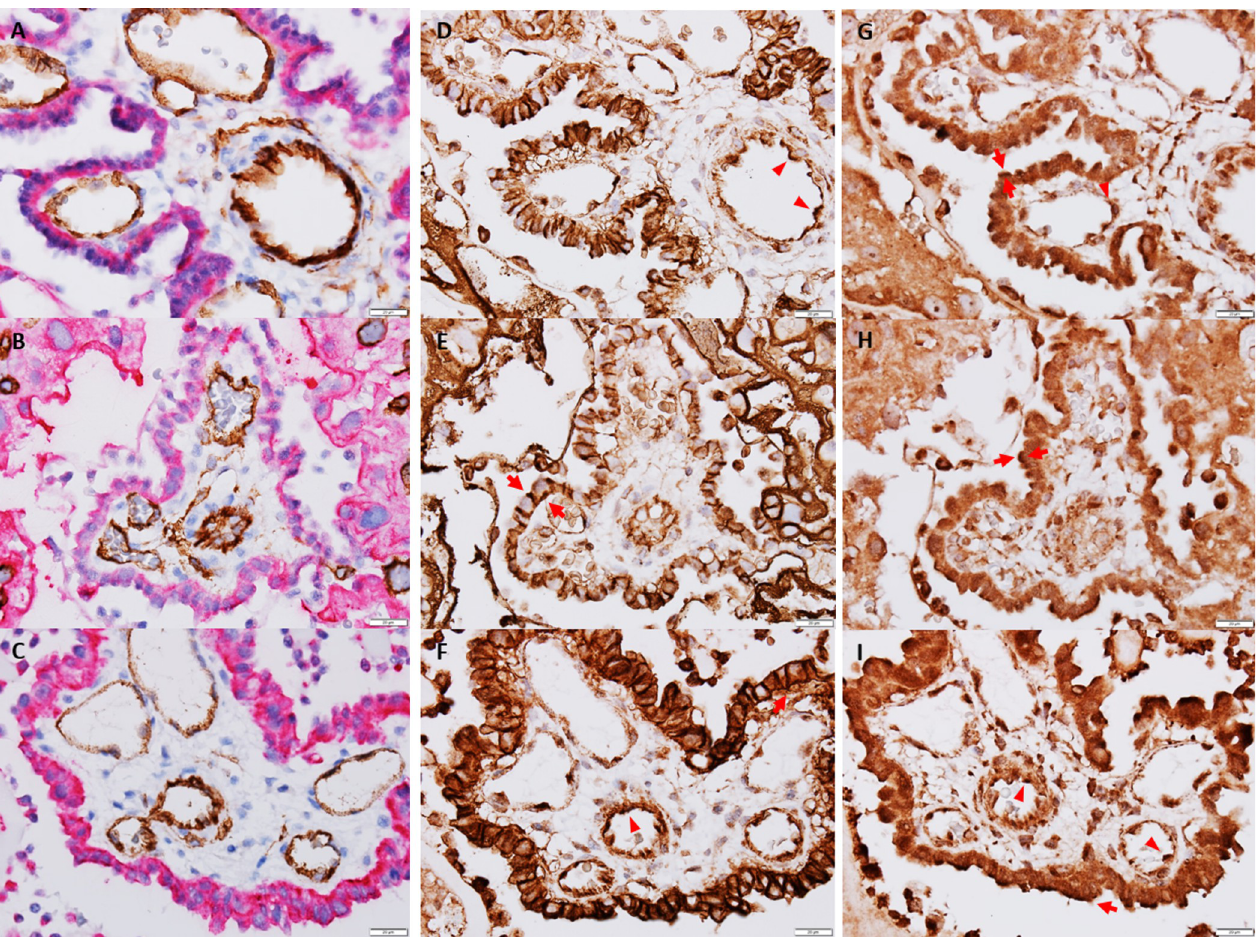
Fig 1. Microscopic images of glucose transporter distribution in placenta on GD20. Left panel (A-C): Double-staining for maternal trophoblasts (pink) and foetal microvascular endothelial cells (dark brown). Middle panel (D-F): GLUT1 (brown staining). In trophoblasts, a strong signal is present in the entire plasma membrane, seen in both the apical and basal membranes, but also in the membranes apposing adjacent trophoblasts (arrows). In foetal endothelial cells, a strong signal is present in the apical membrane (arrow heads). A diffuse signal is seen in the cytoplasm of both cell types. Right panel (G-I): GLUT3 (brown staining). A strong signal is present in the apical plasma membrane of trophoblasts (arrows) and foetal endothelial cells (arrow heads) facing the maternal and foetal circulation, respectively. A, D and G: CTRL group, B, E, and H: HI-GD20 group, C, E, and I: HI-GD17 group. 600 x magnification, scale-bar: 20 μ m.